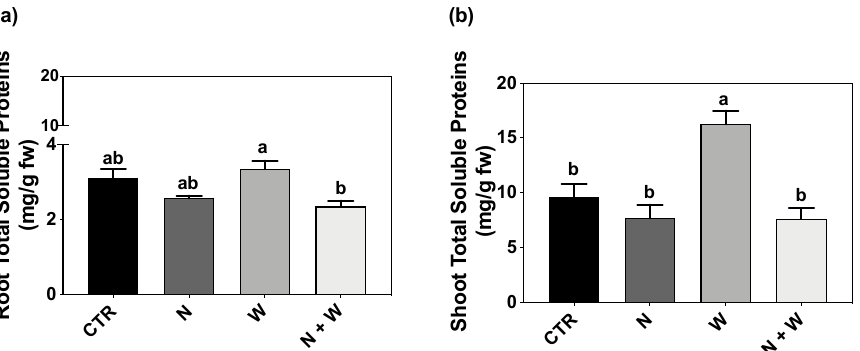
Figure 2. Proline concentration in roots ( a ) and shoots ( b ) of tomato cv. Micro-Tom grown for 16 days under control (CTR; 10.5 mM N + 100% W), nitrogen deficit (N; 5.3 mM N + 100% W), water deficit (W; 10.5 mM N + 50% W) or combined nitrogen and water deficit (N+W; 5.3 mM N + 50% W). 113% higher compared to CTR and N+W-deficit plants, respectively), whereas the other Data presented are mean ± SEM (n = 3). Different letters above bars indicate significant differences treatments did not differ from each other (Figure 3b). according to Tukey’s HSD test ( p = 0.05).